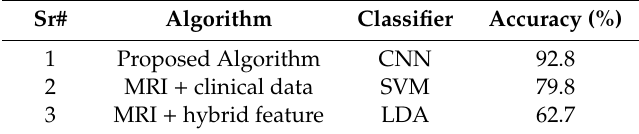
Table 4. Comparative Analysis with Multi-class Classification